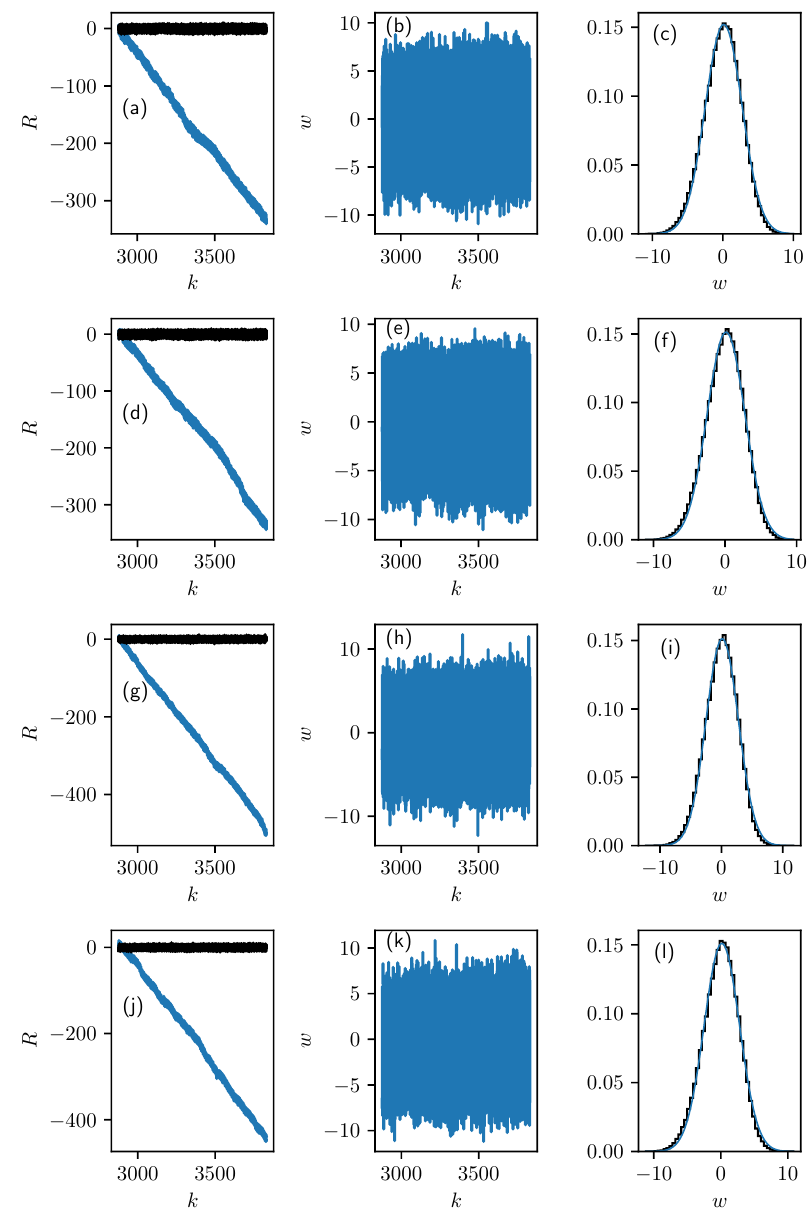
Figure 3. Results for the B = 0.1953 billiard: left column ( a , d , g , j ): the difference, ¯ W ( k ) , between the staircase function, ( k ) ( k ) , around the Weyl function and the Weyl R ( k ) = N − N function as a function of the wavenumber k (in the mean linearly decreasing line); middle column m ( R ( k )) as afunction of k , where m ( R ( k )) is the ( b , e , h , k ): the fluctuation quantity, w ( k ) = R ( k ) − local average of R ( k ) over 100 consecutive levels; right column ( c , f , i , l ): the distribution of w . The rows top to bottom refer to the symmetry classes odd-odd, odd-even, even-odd, and even-even, respectively. In each parity case, there are about 300,000 levels. The agreement with the Gaussian distribution is extremely good. The small shift of the maximum around w 0.1 is due to the ≈ imperfection of local averaging. The values of the mean, µ , and the standard deviation, σ are (top to bottom): (0.126, 2.624), (0.139, 2.636), (0.132, 2.635), (0.148, 2.641), respectively. Within the expected statistical error, the value of σ is the same for all parities. The same analysis was performed for the case of the B = 0.083 billiard, and the results are shown in Figure 4, and lead to the same